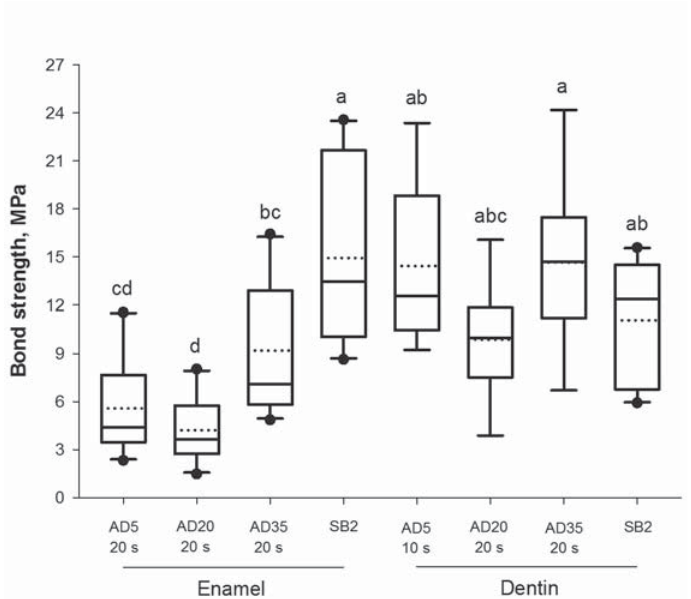
Figure 3- Results for enamel and dentin bond strengths of the commercial adhesive and the adhesive-rubbing time combinations with (cid:87)(cid:75)(cid:72)(cid:3)(cid:75)(cid:76)(cid:74)(cid:75)(cid:72)(cid:86)(cid:87)(cid:3)(cid:80)(cid:72)(cid:68)(cid:81)(cid:86)(cid:3)(cid:73)(cid:82)(cid:85)(cid:3)(cid:72)(cid:68)(cid:70)(cid:75)(cid:3)(cid:86)(cid:88)(cid:69)(cid:86)(cid:87)(cid:85)(cid:68)(cid:87)(cid:72)(cid:3)(cid:11)(cid:81)(cid:32)(cid:20)(cid:19)(cid:12)(cid:17)(cid:3)(cid:54)(cid:82)(cid:79)(cid:76)(cid:71)(cid:3)(cid:68)(cid:81)(cid:71)(cid:3)(cid:71)(cid:82)(cid:87)(cid:87)(cid:72)(cid:71)(cid:3)(cid:75)(cid:82)(cid:85)(cid:76)(cid:93)(cid:82)(cid:81)(cid:87)(cid:68)(cid:79)(cid:3)(cid:79)(cid:76)(cid:81)(cid:72)(cid:86)(cid:3)(cid:76)(cid:81)(cid:71)(cid:76)(cid:70)(cid:68)(cid:87)(cid:72)(cid:3)(cid:80)(cid:72)(cid:71)(cid:76)(cid:68)(cid:81)(cid:86)(cid:3)(cid:68)(cid:81)(cid:71)(cid:3)(cid:80)(cid:72)(cid:68)(cid:81)(cid:86)(cid:15)(cid:3)(cid:85)(cid:72)(cid:86)(cid:83)(cid:72)(cid:70)(cid:87)(cid:76)(cid:89)(cid:72)(cid:79)(cid:92)(cid:17)(cid:3)(cid:39)(cid:76)(cid:86)(cid:87)(cid:76)(cid:81)(cid:70)(cid:87)(cid:3)(cid:79)(cid:72)(cid:87)(cid:87)(cid:72)(cid:85)(cid:86)(cid:3) Table 2- (cid:41)(cid:85)(cid:72)(cid:84)(cid:88)(cid:72)(cid:81)(cid:70)(cid:76)(cid:72)(cid:86)(cid:3)(cid:82)(cid:73)(cid:3)(cid:73)(cid:68)(cid:76)(cid:79)(cid:88)(cid:85)(cid:72)(cid:3)(cid:80)(cid:82)(cid:71)(cid:72)(cid:86)(cid:3)(cid:73)(cid:82)(cid:85)(cid:3)(cid:68)(cid:79)(cid:79)(cid:3)(cid:74)(cid:85)(cid:82)(cid:88)(cid:83)(cid:86)